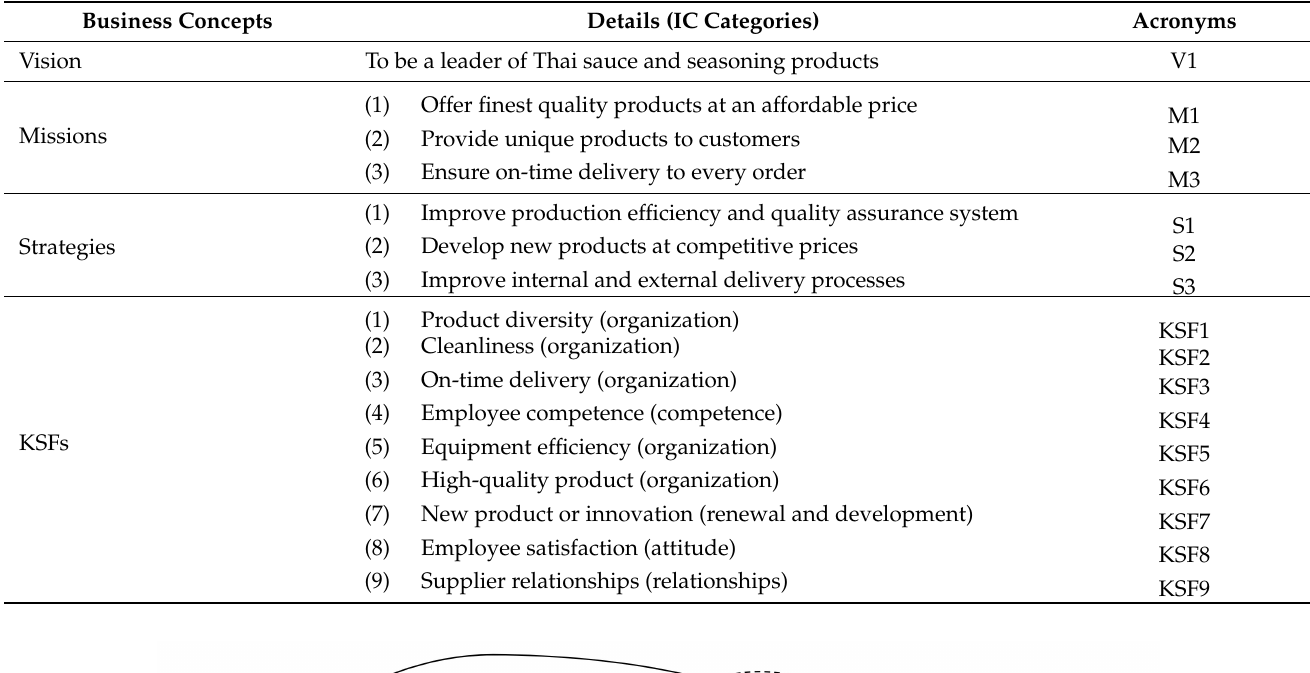
Table 2. Business-related concepts and KSFs of the case study.